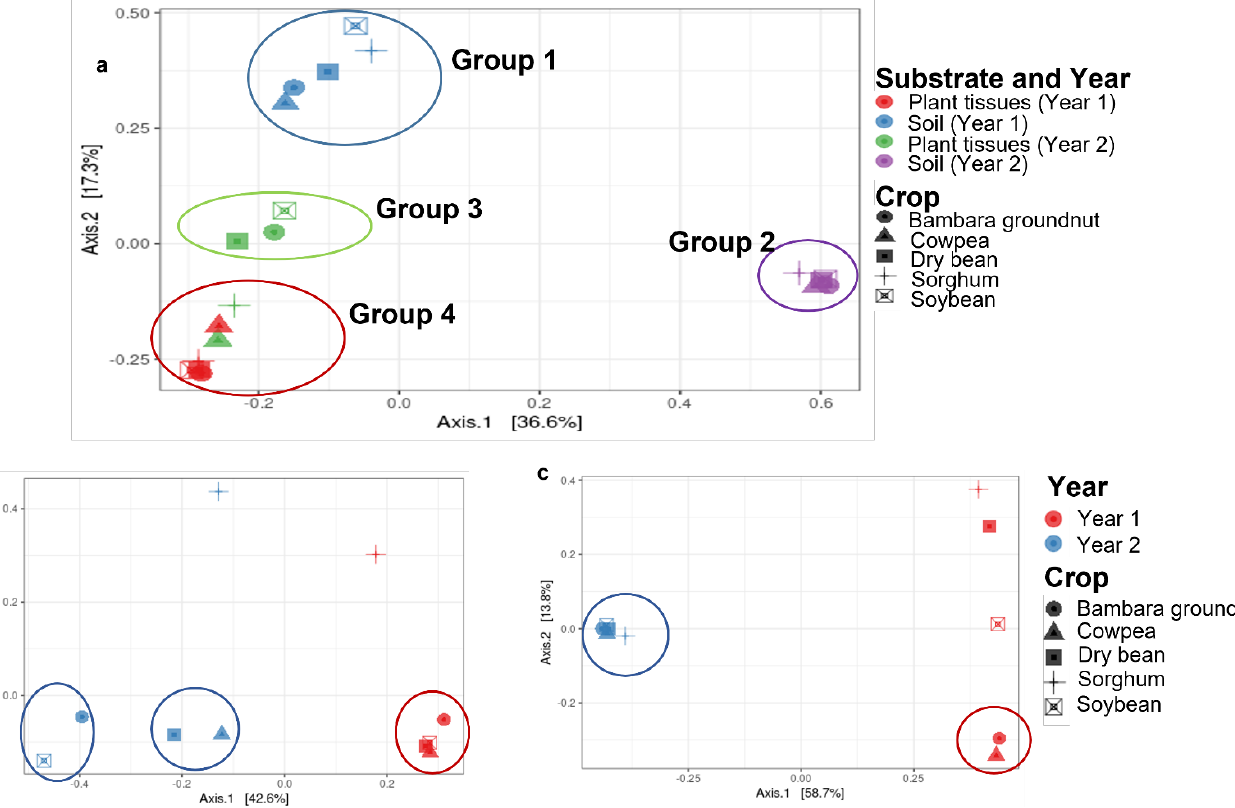
Figure 2. Fungal diversity of the core mycobiome. The pie chart illustrates the diversity richness of fungal MOTUs per crop. MOTUs with an asterisk (*) indicate the core across crops.